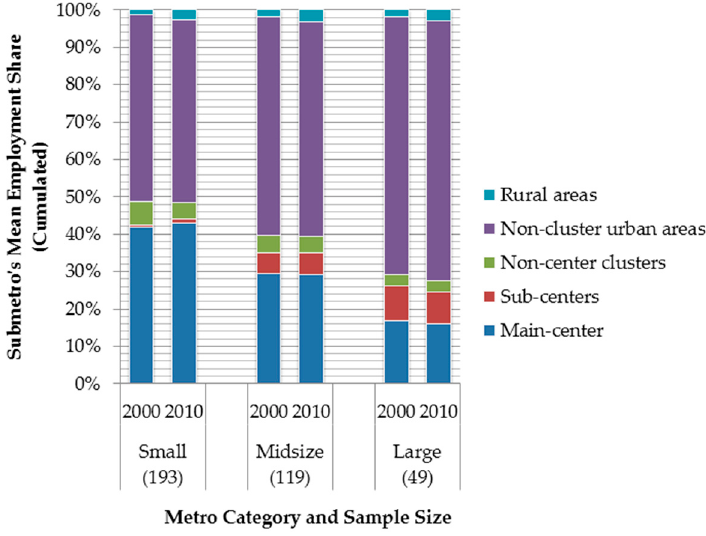
Figure 4. Three metro categories’ mean employment shares in five submetro sections in 2000 and 2010.